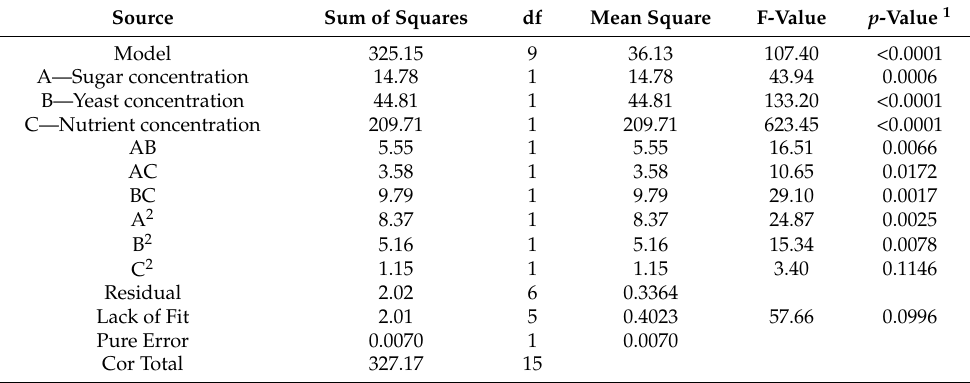
Table 4. ANOVA table of CCD-RSM used to optimise the fermentation of diluted sugar beet molasses using S. cerevisiae